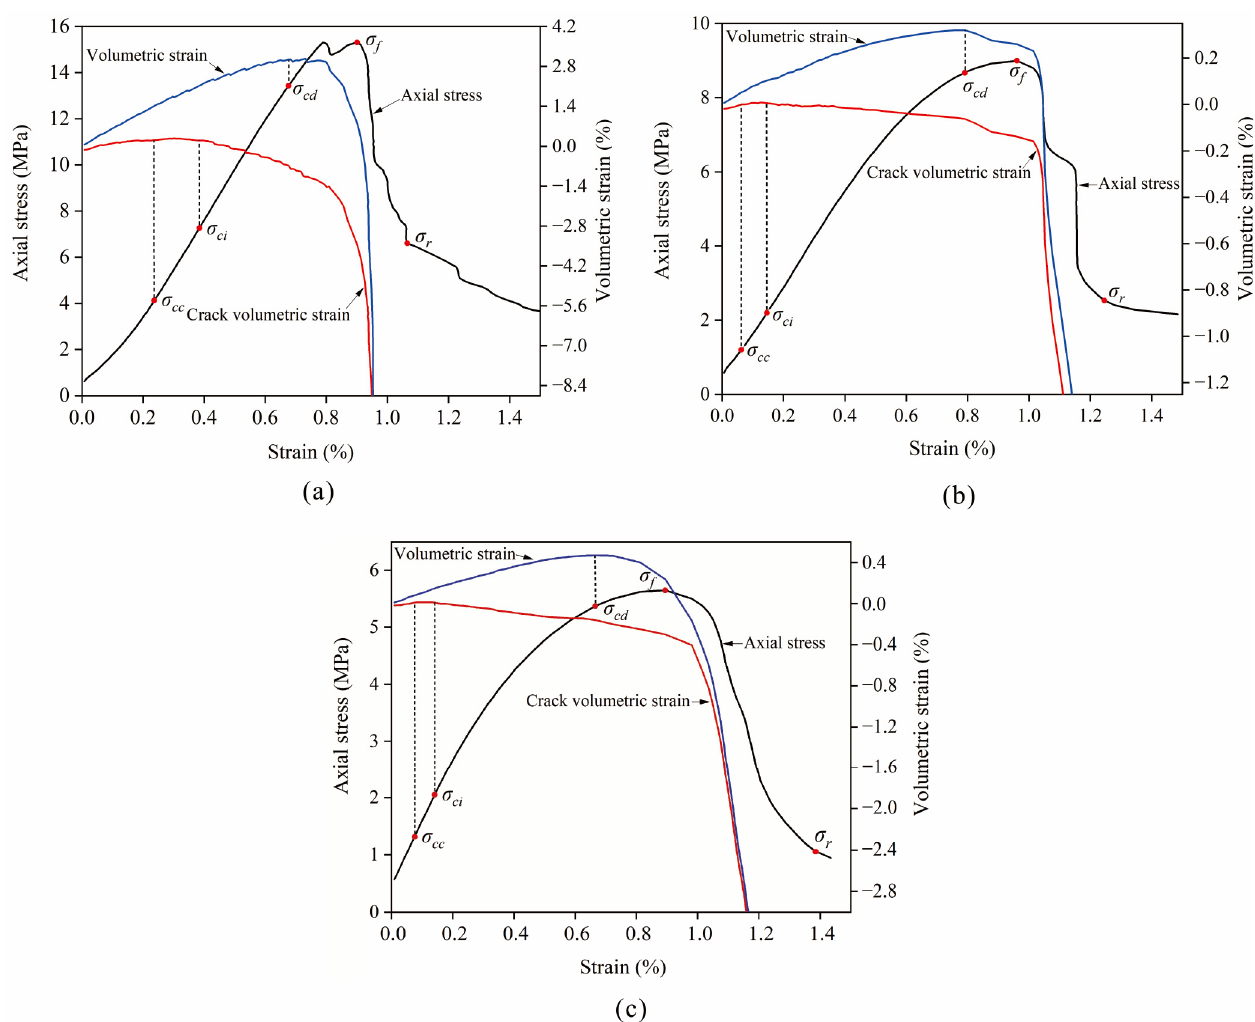
Figure 6. Crack volumetric strain curves, volumetric strain curves, and stress–strain curves of specimens with different ratios of aggregates to binders: ( a ) 1:1; ( b ) 4:1; and ( c ) 7:1.